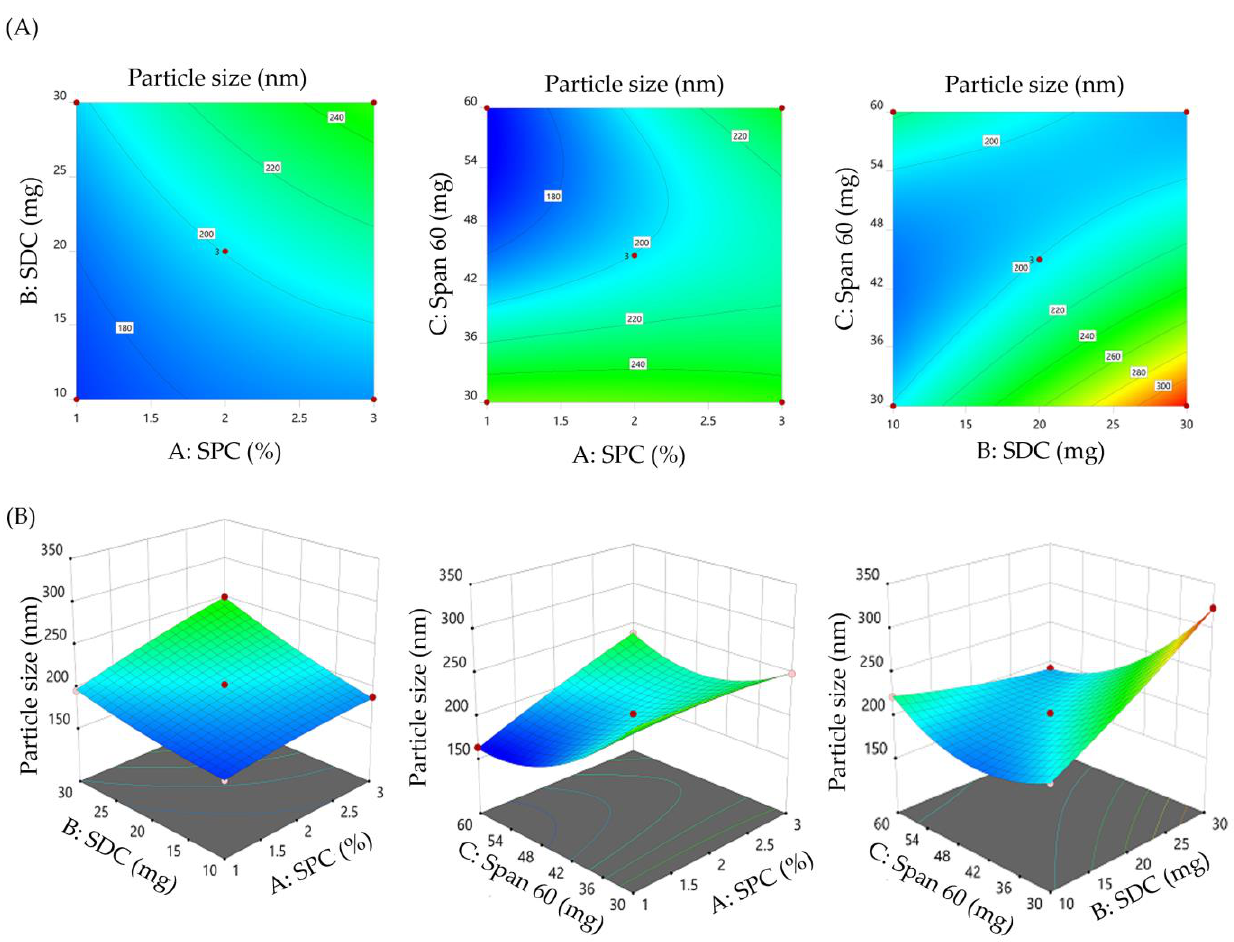
Figure 1. Effect of formulation variables on vesicle size (Y 1 ). ( A ) Contour plots of Y 1 and ( B ) 3D surface plots for Y 1 .